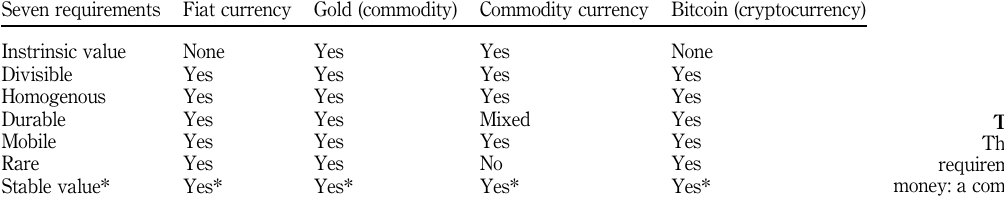
Table I. The seven requirements of money: a